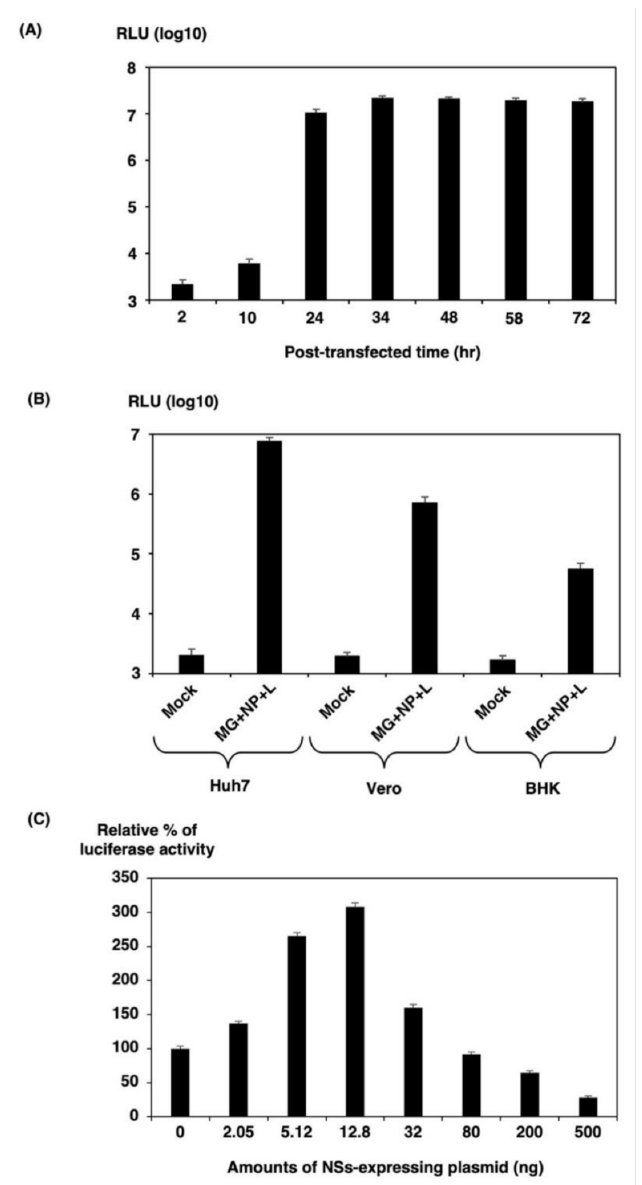
Figure 3. 293T cells in a 12-well plate were transfected with 300 ng of MG plasmid along with the necessary supporting plasmids (300 ng of NP and 1500 ng of pKS-SFTSV-L) per well. ( A )